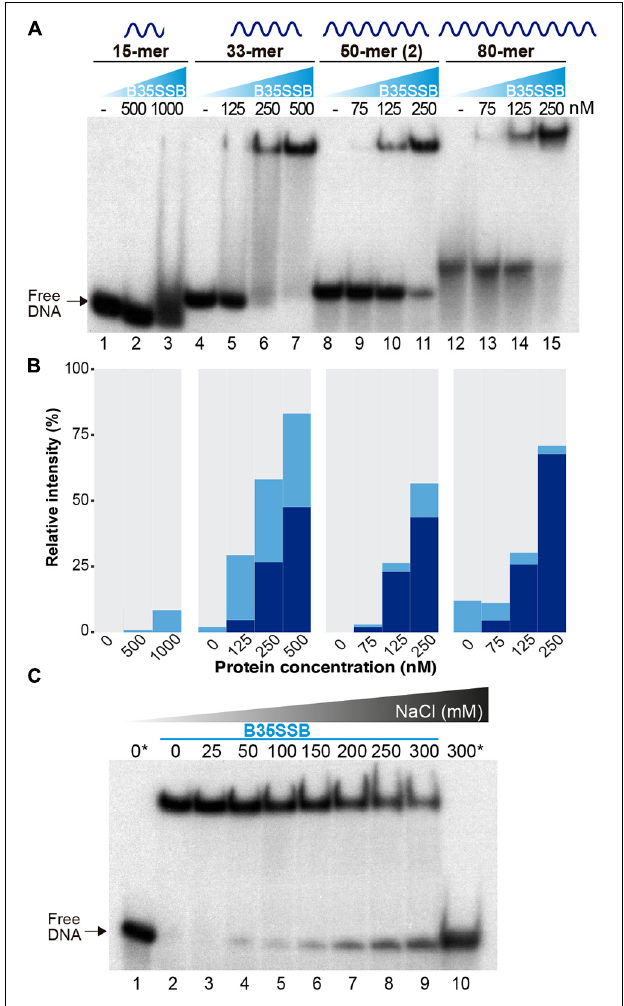
FIGURE 3 | Characterization of cooperative DNA binding. The effect of substrate DNA length in ssDNA binding as determined by oligonucleotides of the indicated length was analyzed by EMSA (A) and quantified by gel densitometry with ImageJ (B) . Note that a lower B35SSB concentration range was used for longer ssDNA fragments. (C) DNA binding assay in the presence of increasing concentrations of NaCl. Samples were prepared in a sample buffer without salt and were supplemented with NaCl to obtain the indicated extra salt concentration. The reactions also contained a basal concentration (12.7 mM NaCl) contributed by the reaction components. Samples with no protein are indicated with an